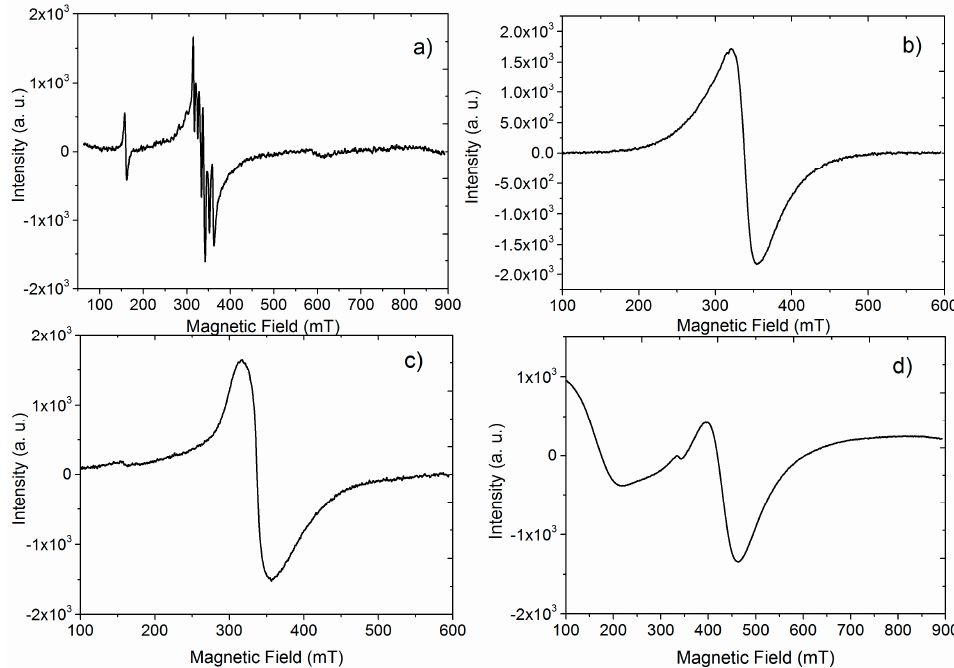
Figure 3. EPR spectra: ( a ) KNNLM05; ( b ) KNNLM1; ( c ) KNNEF05 and ( d ) KNNEF1.